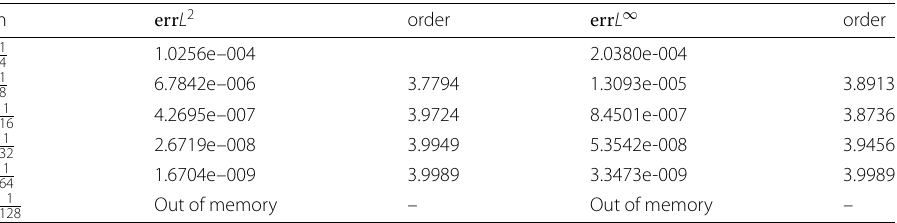
Table 6 The comparison of the l 2 -norm and the l ∞ -norm when τ = h x = h y for O ( h 2 x + h 2 y ) standard central difference scheme, at different values of the step size (for N = 4,8,16,32,64,128) in the x and y directions h err L 2 order err L ∞ order 1 4